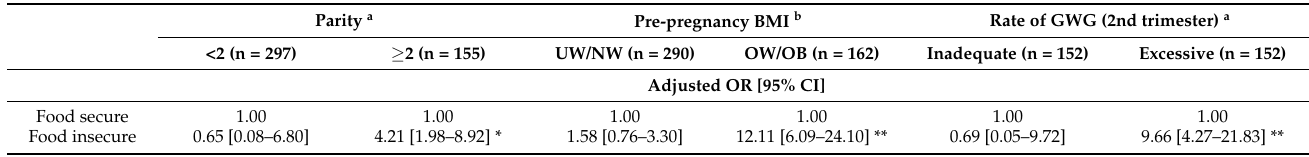
Table 4. Adjusted odds ratio (OR) and 95% confidence intervals (95% CI) for associations between household food security and gestational diabetes mellitus (GDM) stratified by parity, pre-pregnancy BMI and rate of GWG (2nd trimester). Parity a Pre-pregnancy BMI b Rate of GWG (2nd trimester) a <2 (n = 297) ≥ 2 (n = 155) UW/NW (n = 290) OW/OB (n = 162) Inadequate (n = 152) Excessive (n = 152) Adjusted OR [95% CI] Food